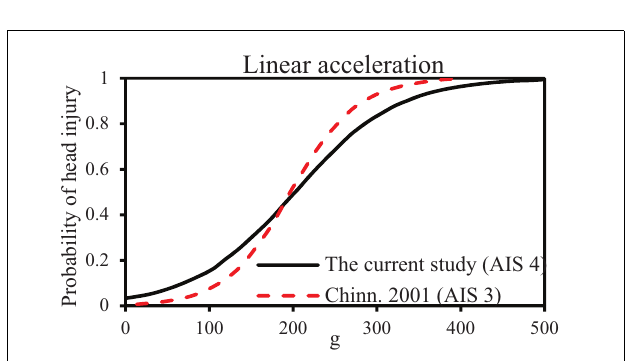
FIGURE 7 | Comparison of the head injury criteria (HIC) risk curves for head AIS 4+